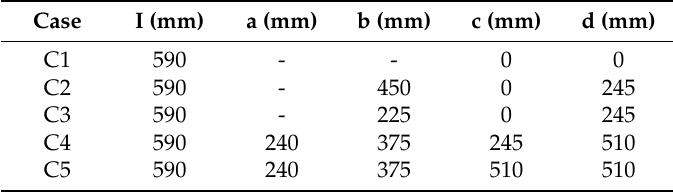
Figure 4. Front view of the optimized tundish structure in the isothermal experiment Part C. Table 5. Scheme of the isothermal experiment Part C.